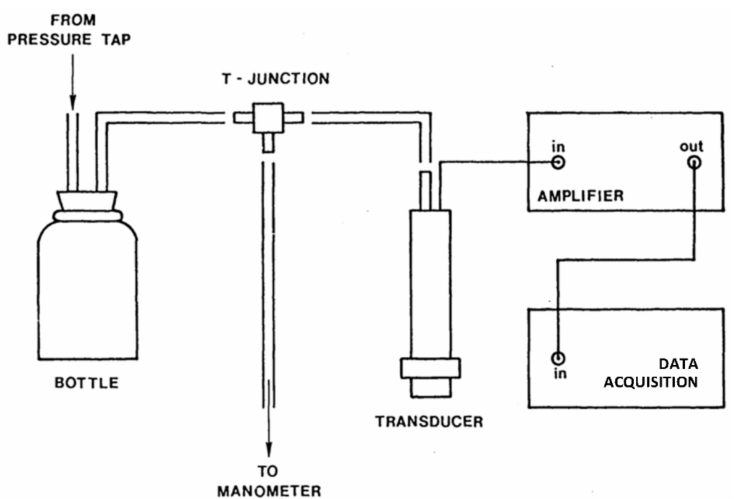
Figure 2. Schematic drawing of the pressure data acquisition system. The bottle was used as a large reservoir to mechanically dampen the pressure fluctuations. The pressure could be monitored using an oil manometer